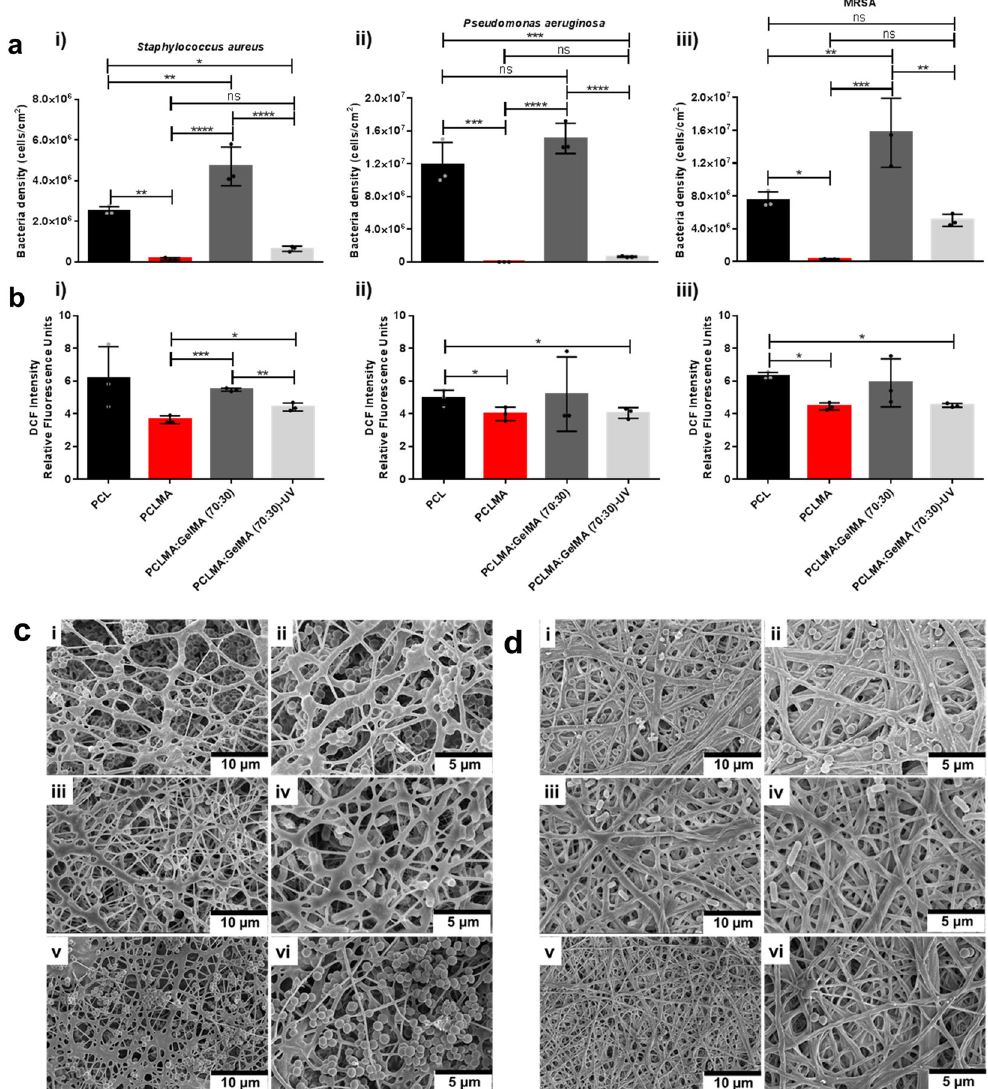
Fig. 7 Bactericidal results on the various fi bers (1 cm×1 cm) after 23 h. a The colony-forming unit data for i Staphylococcus aureus ( S. aureus ), ii Pseudomonas aeruginosa ( P. aeruginosa ), and iii Methicillin-resistant Staphylococcus aureus (MRSA). b Reactive oxygen species (ROS) generated from fi bers against i S. aureus ii P. aeruginosa and iii MRSA. Values are mean ± SD, N = 9. ANOVA ( p < 0.05) following by Tukey ’ s multiple comparisons test, * p < 0.05, ** p < 0.01, *** p < 0.005 **** p < 0.001, ns not signi fi cant, mean statistical differences. Scanning electron microscopy (SEM) images of the c PCLMA:GelMA (70:30) fi bers pre-treated with the bio fi lm-forming i, ii S. aureus , iii, iv P. aeruginosa , and v, vi MRSA for 23 h, shown at high (scale bar 10 μ m) and